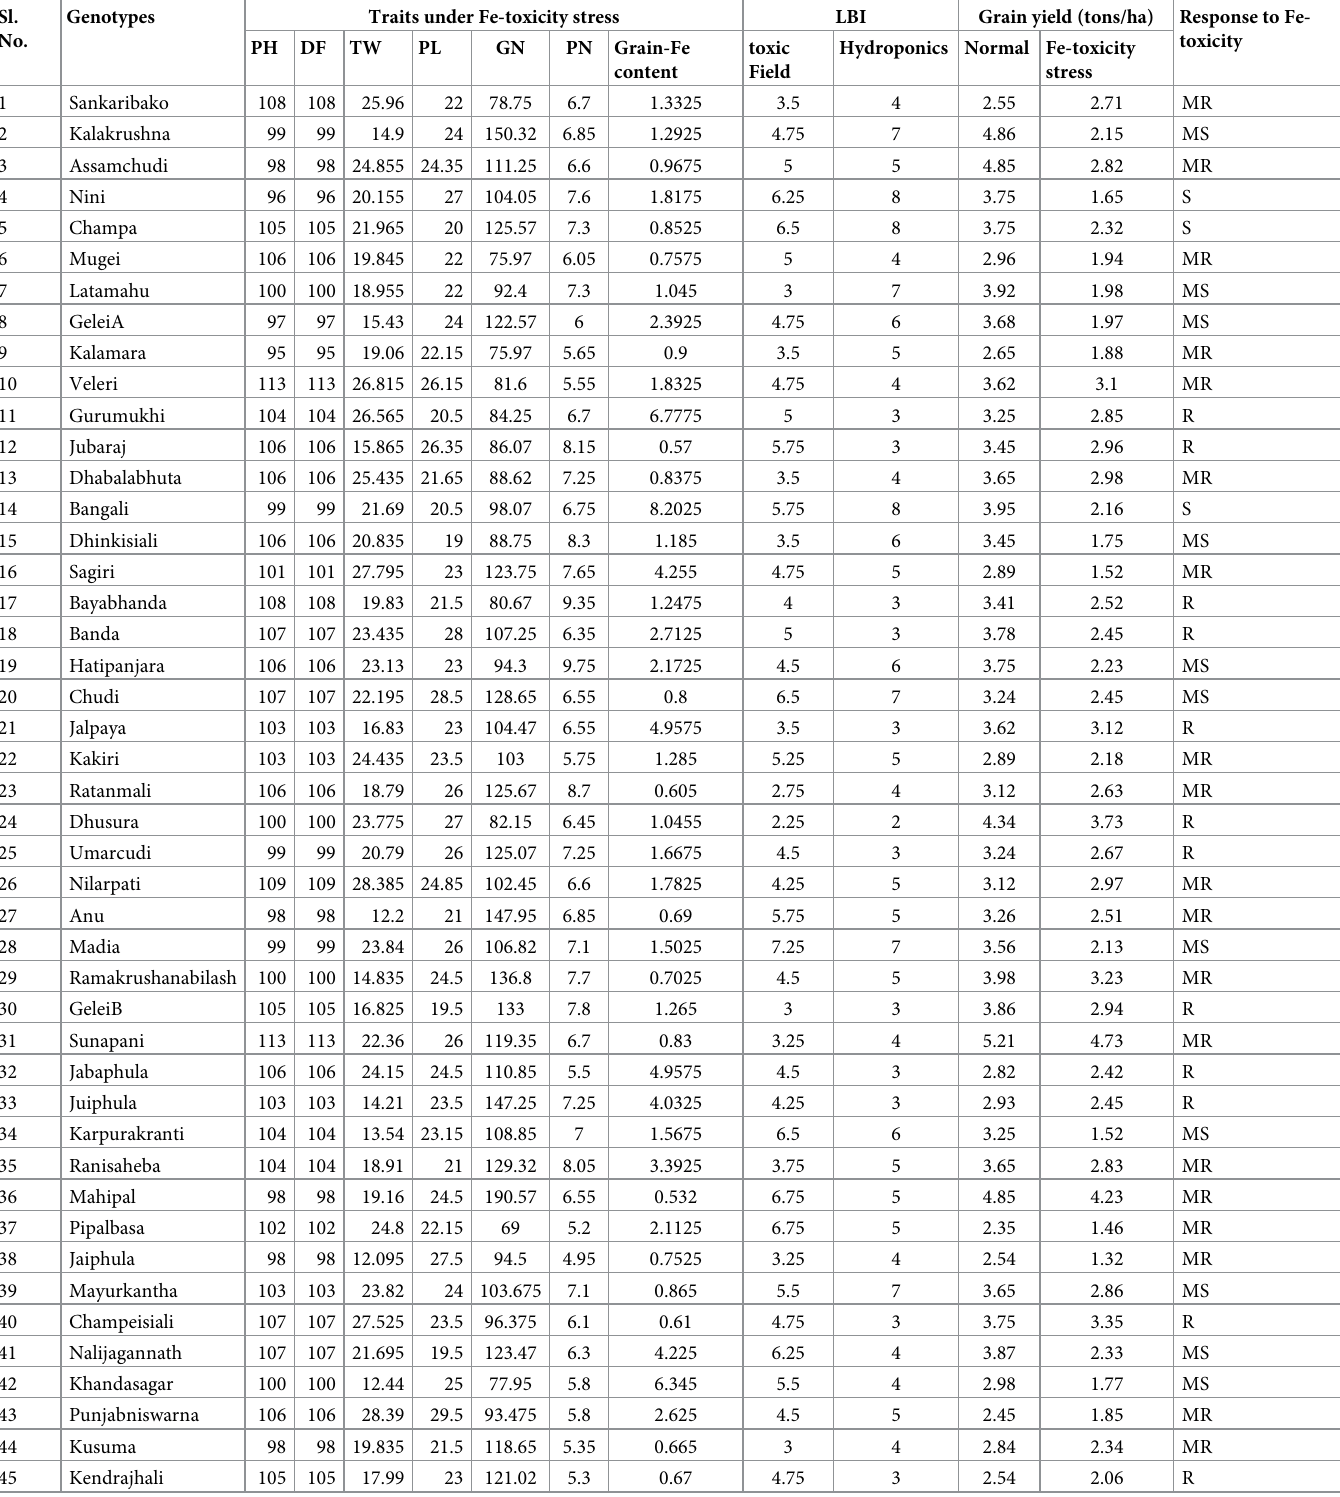
Table 1. Mean leaf bronzing, Fe-content, grain yield and component traits in the shortlisted genotypes under Fe-toxicity stress during wet season, 2017 and 2018. Sl.